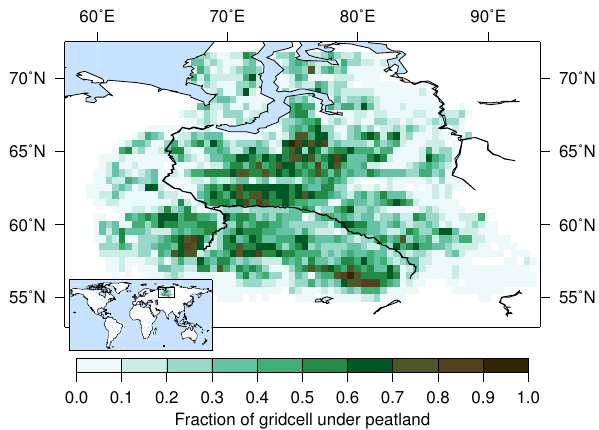
Fig. 3. Fraction of land covered by peatlands at present in the West Siberian Lowlands. Data were taken from Sheng et al. (2004) and aggregated to a 0 . 5 ◦ × 0 . 5 ◦ grid by T. Bohn.